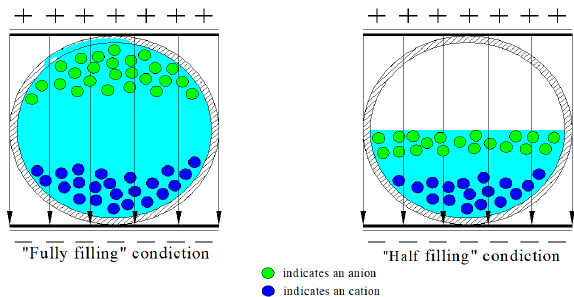
Fig. 2. Diagram of the distribution of anions and cations under uniform electrostatic field